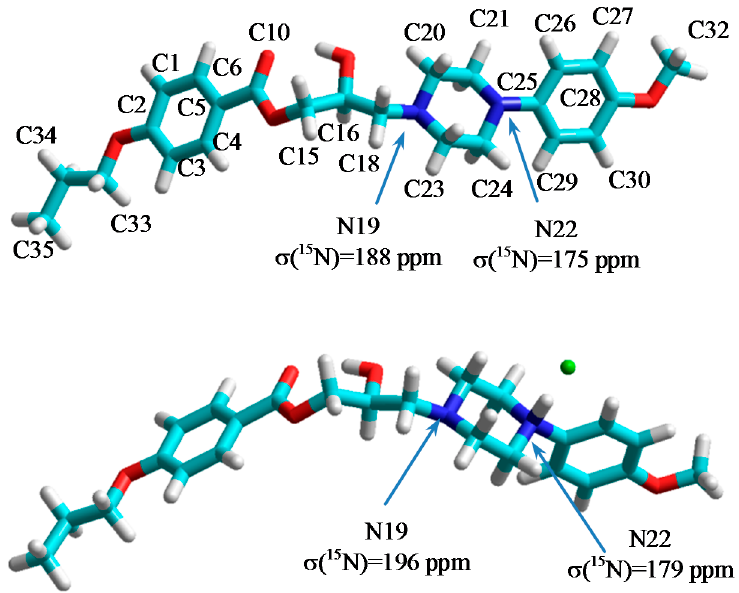
Figure 1. DFT optimized structure of base 3e (R = 4-OCH 3 ) and its predicted DFT optimized monohydrochloride salt 4e (R = 4-OCH 3 ), carbon and nitrogen unit numbering and calculated 15 N-NMR isotropic shielding parameters σ ( 15 N).